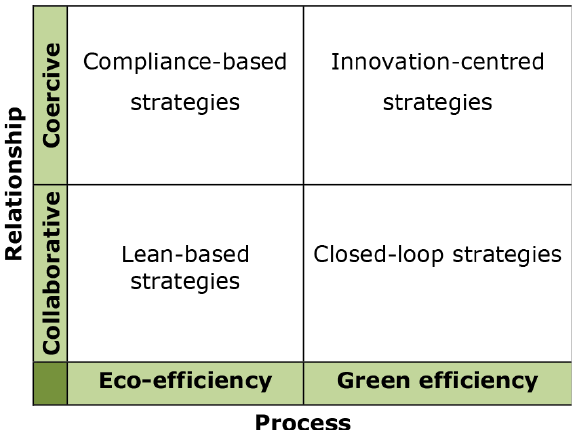
Figure 4. Relationship-Process characteristics and green strategies